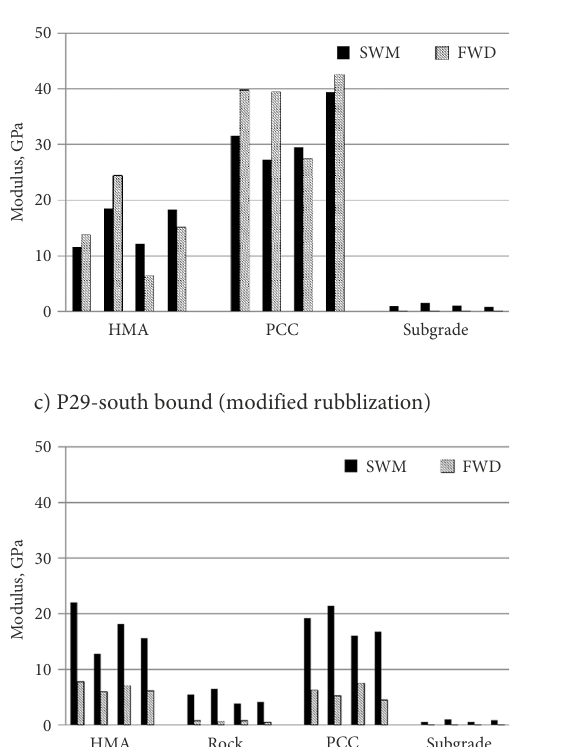
Figure 3. Comparison of FWD and SWM